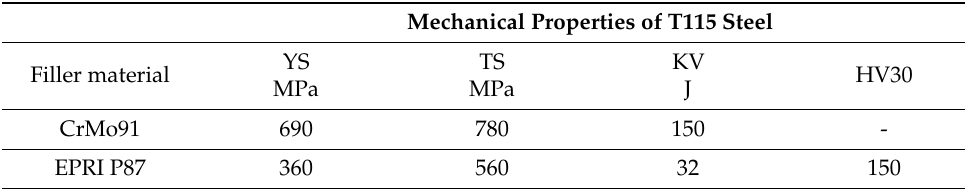
Table 4. Mechanical properties of CrMo91 and EPRI P87 filler materials.